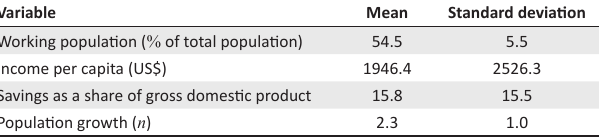
FIGURE 4: Savings and economic growth. TABLE 4: Descriptive statistics of the model